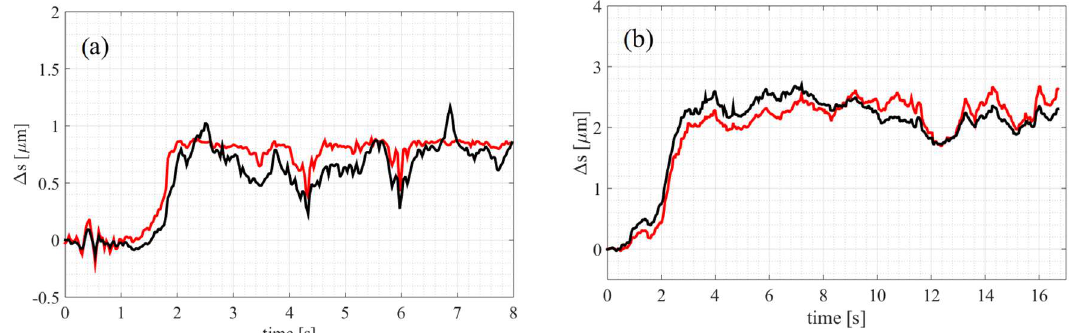
Figure 7. Fluid viscosities can be compared by measuring the trapping beam-bead displacement in an accelerating tool. The displacements of the front (black) and rear (red) beads for the tool moving in water ( a ) and the 30% glycerol solution ( b ). At the beginning, the velocity increases (first 2 and 3 s, respectively) and then remains constant.